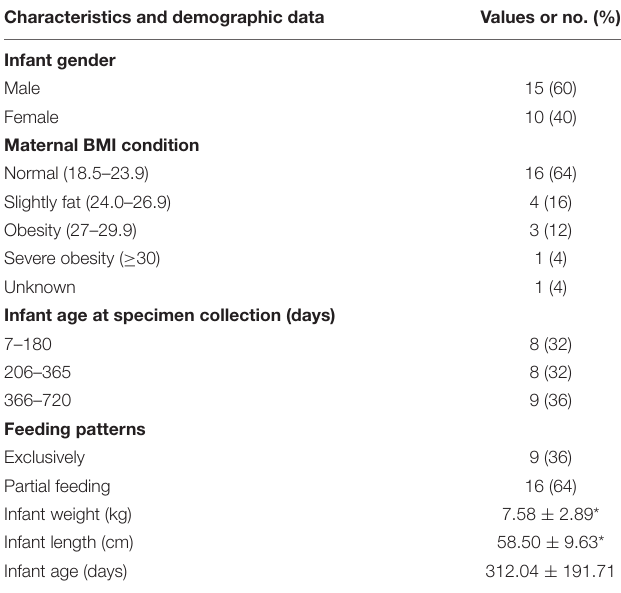
TABLE 1 | Demographic characteristics of our cohort. Characteristics and demographic